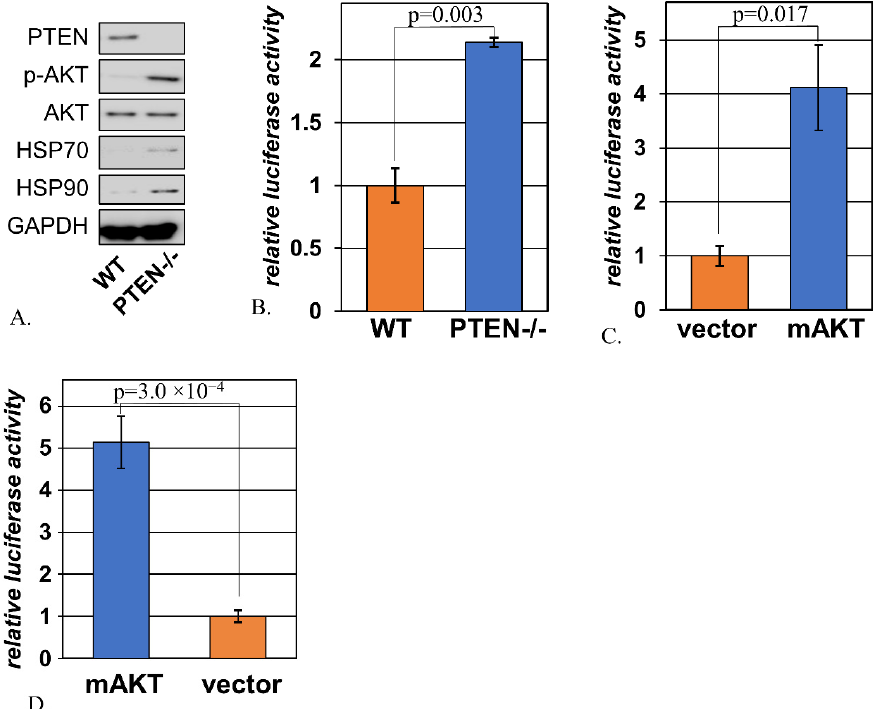
Figure 1. The loss of PTEN and activation of AKT trigger the heat shock response. ( A ). The lysates from MEF PTEN-/- and MEF WT cells were probed by immunoblotting with the indicated antibody. ( B ). The activity of the HSF1-driven luciferase reporter was measured upon transient transfection into MEF WT and MEF PTEN-/- cells. The data from triplicate experiments are shown relative to the average values in MEF WT. ( C ). The activity of the HSF1-driven luciferase reporter was measured upon transient co-transfection into MEF-AG cells with either an activated form of mouse AKT1 (mAKT) or the corresponding vector control. The data from triplicate experiments is shown relative to the average values in vector- transfected cells. ( D ). The activity of the HSF1-driven luciferase reporter was measured upon transient co-transfection into human 293T cells with either an activated form of mouse AKT1 (mAKT) or the corresponding vector control. The data from triplicate experiments are shown relative to the average values in vector-transfected